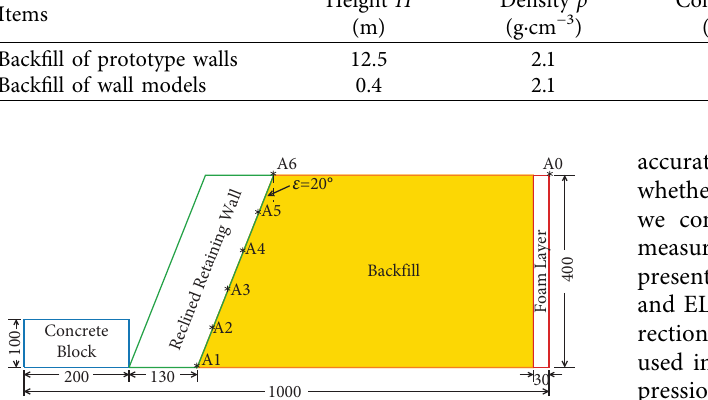
Figure 2: Accelerometer layout and embedding of monitors (unit: mm).